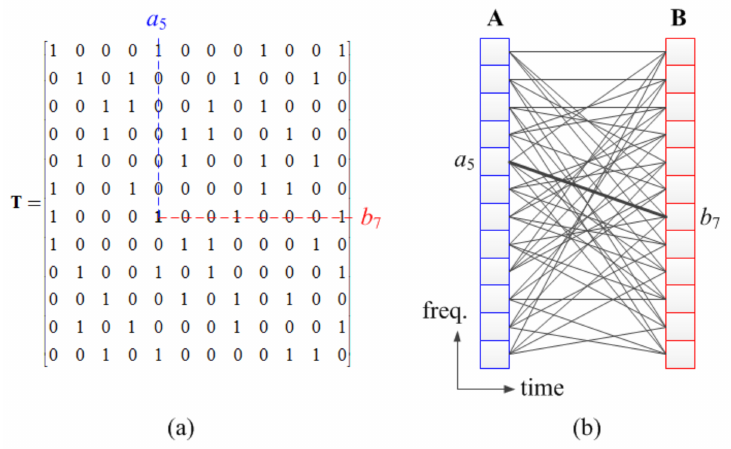
Figure 2. ( a ) Example of trellis matrix T ; ( b ) Corresponding trellis